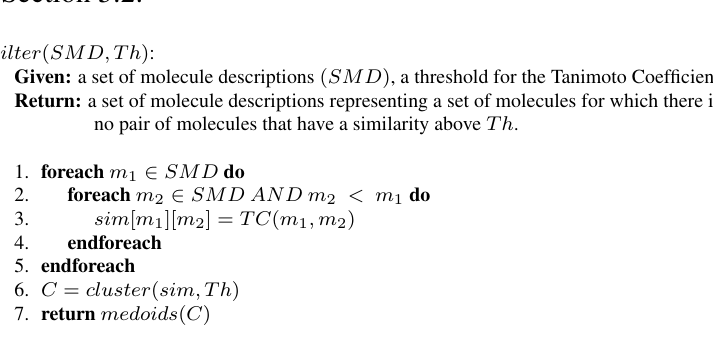
Figure 3: Filtering procedure using the Tanimoto coefficient. sim is a lower triangular similarity matrix. TC() is a function that computes the Tanimoto coefficient between two molecules. cluster() is a procedure that clusters molecules that are “more similar” than the Th value. medoids() returns for each cluster the medoid molecule.